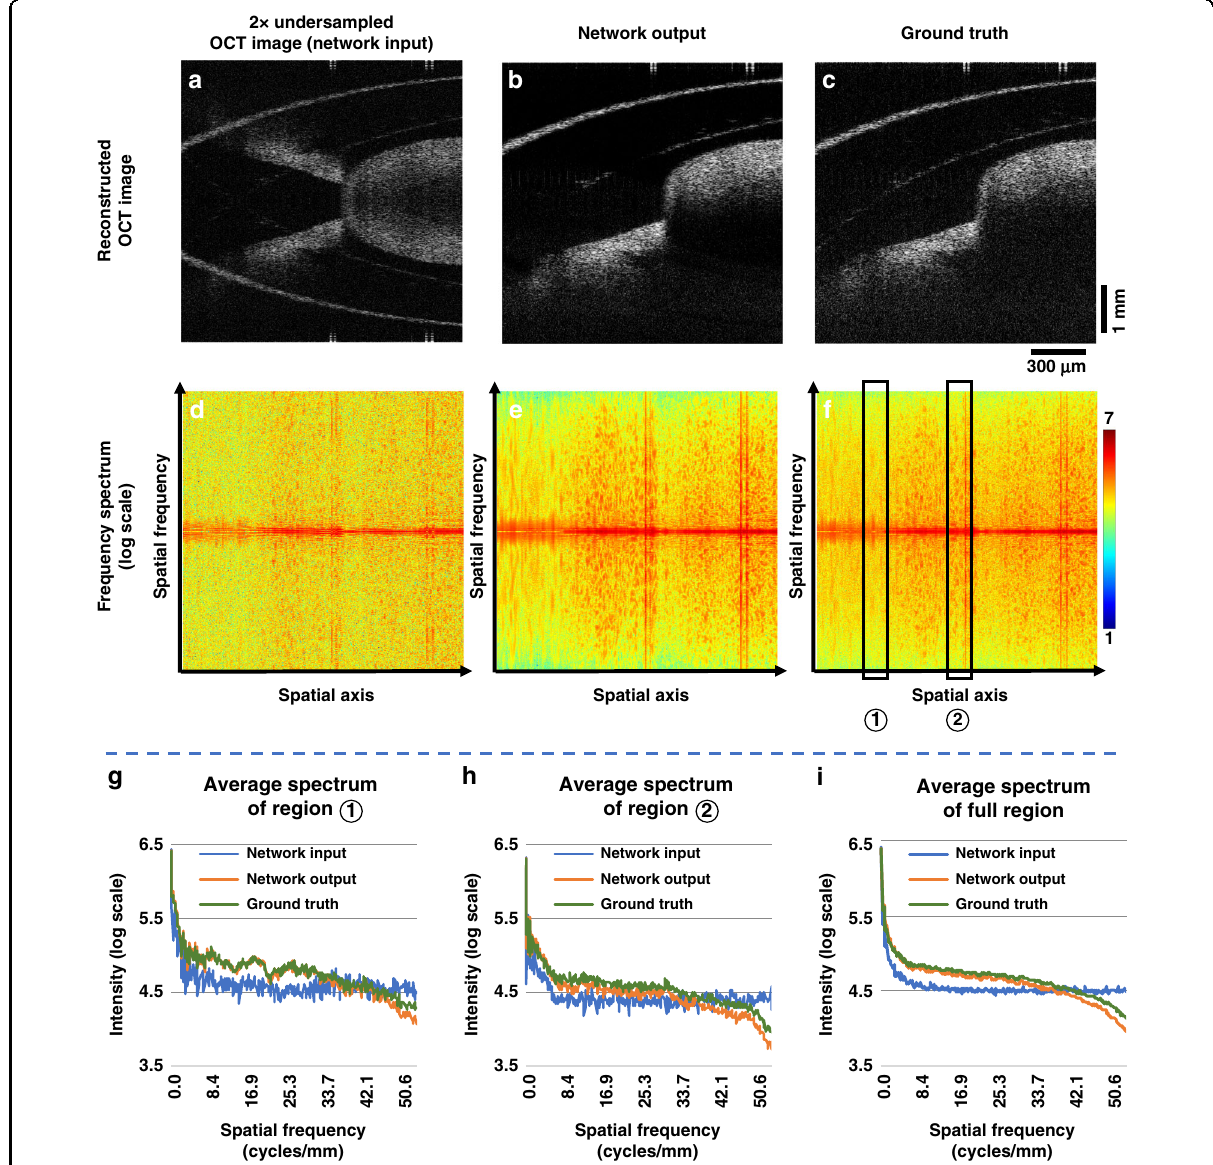
Fig. 3 Frequency spectrum analysis of DL-OCT. a – c SS-OCT images of a sample fi eld-of-view, forming the network input, network output and ground truth, respectively. d – f Log-scaled spatial frequency spectra of a – c represented in spectral-spatial domain using 1D Fourier transform along the A-line direction of each image. g , h Averaged intensity of the spectral pro fi le over two speci fi c spatial regions ( ➀ and ➁ shown in f ). i is the same as in g , h , except that it is averaged over the entire spatial axis, shown in d – f